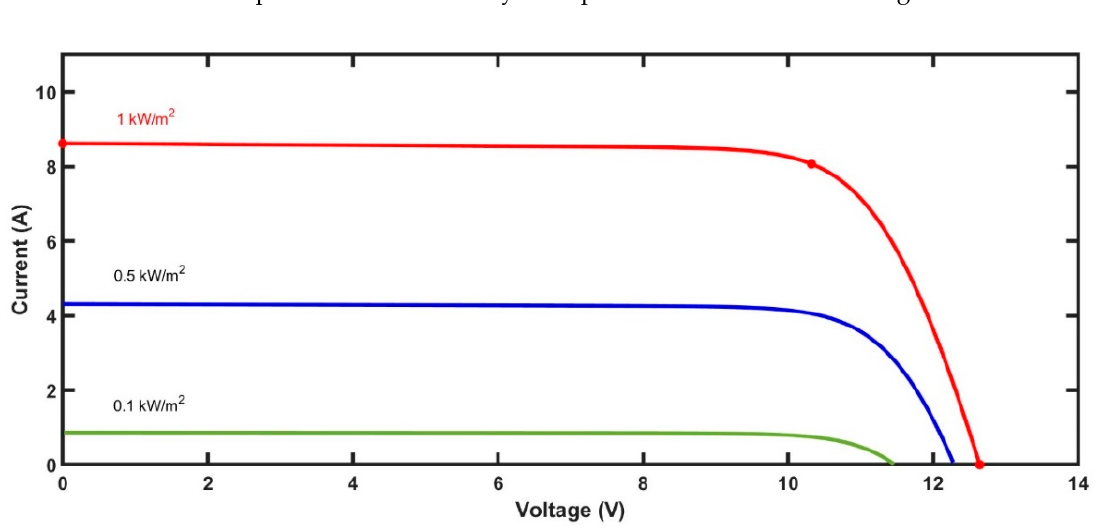
Figure 2. Variation in operating points with respect to the load line.